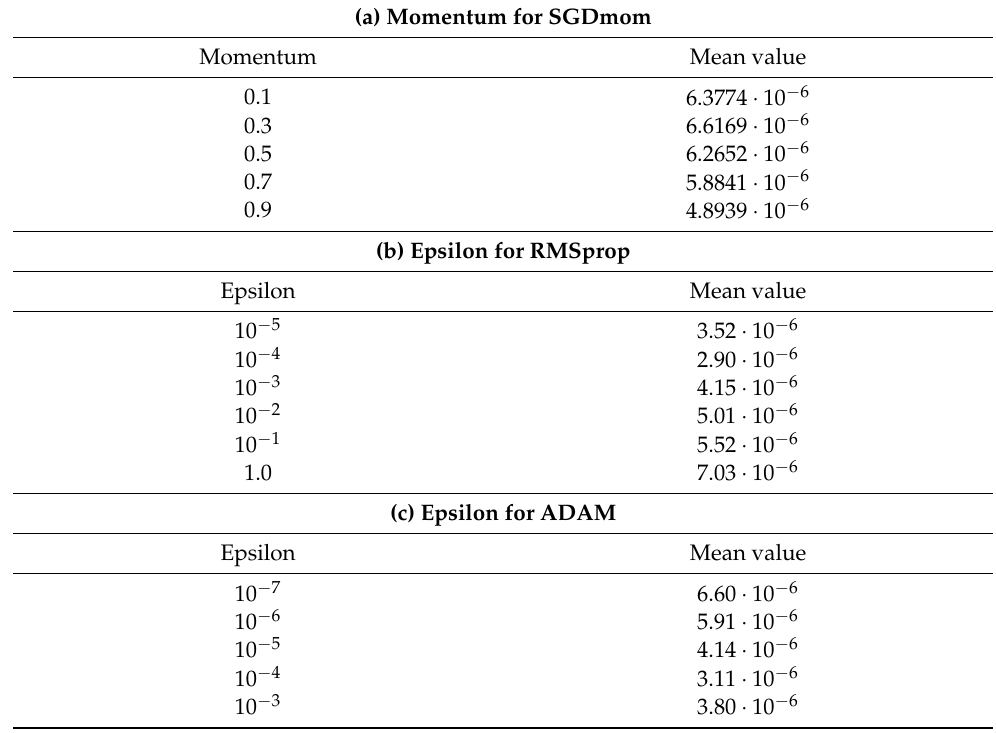
Table 6. Mean value for the error according to the momentum and epsilon.